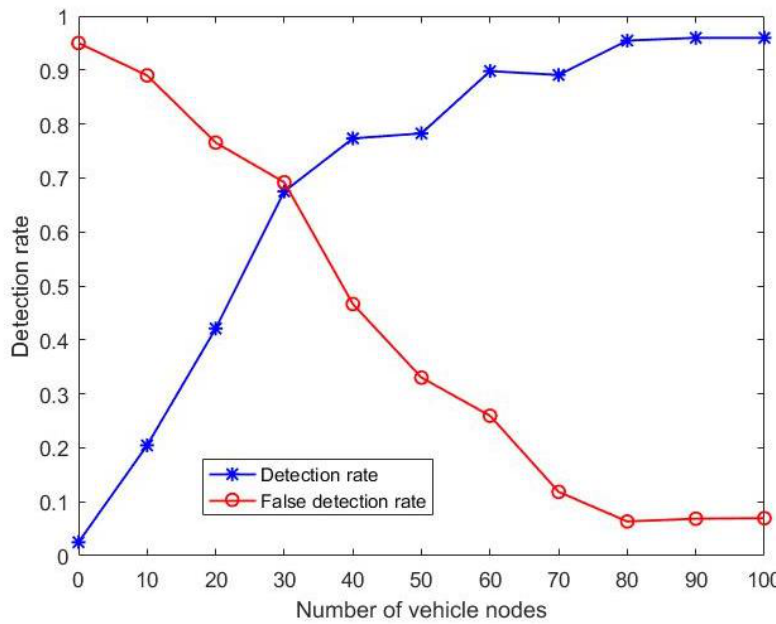
Figure 9. Simulation results of system detection rate and false detection rate.